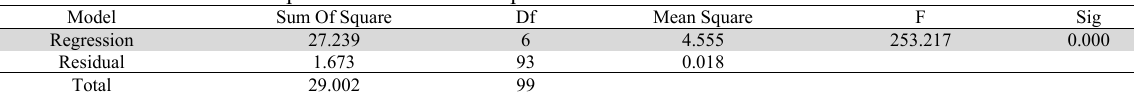
Simultaneous Influence of Independent Variable on Dependent